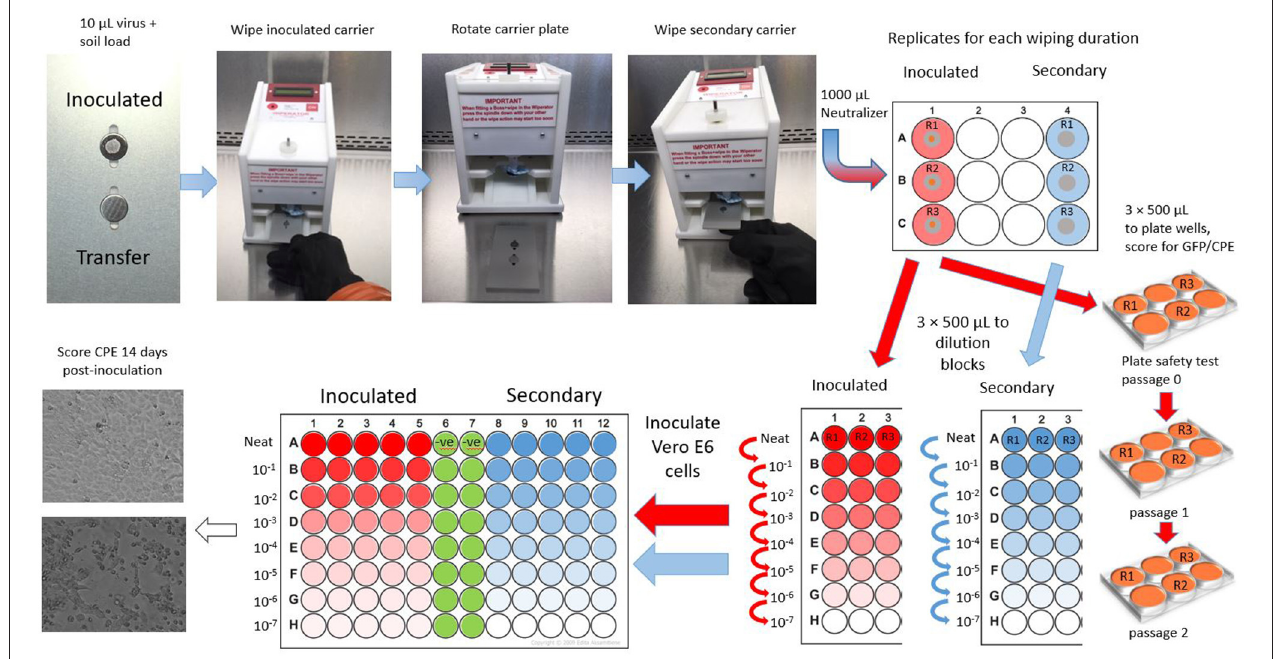
FIGURE 1 | Schematic representation of the inactivation/removal testing methodology employed.